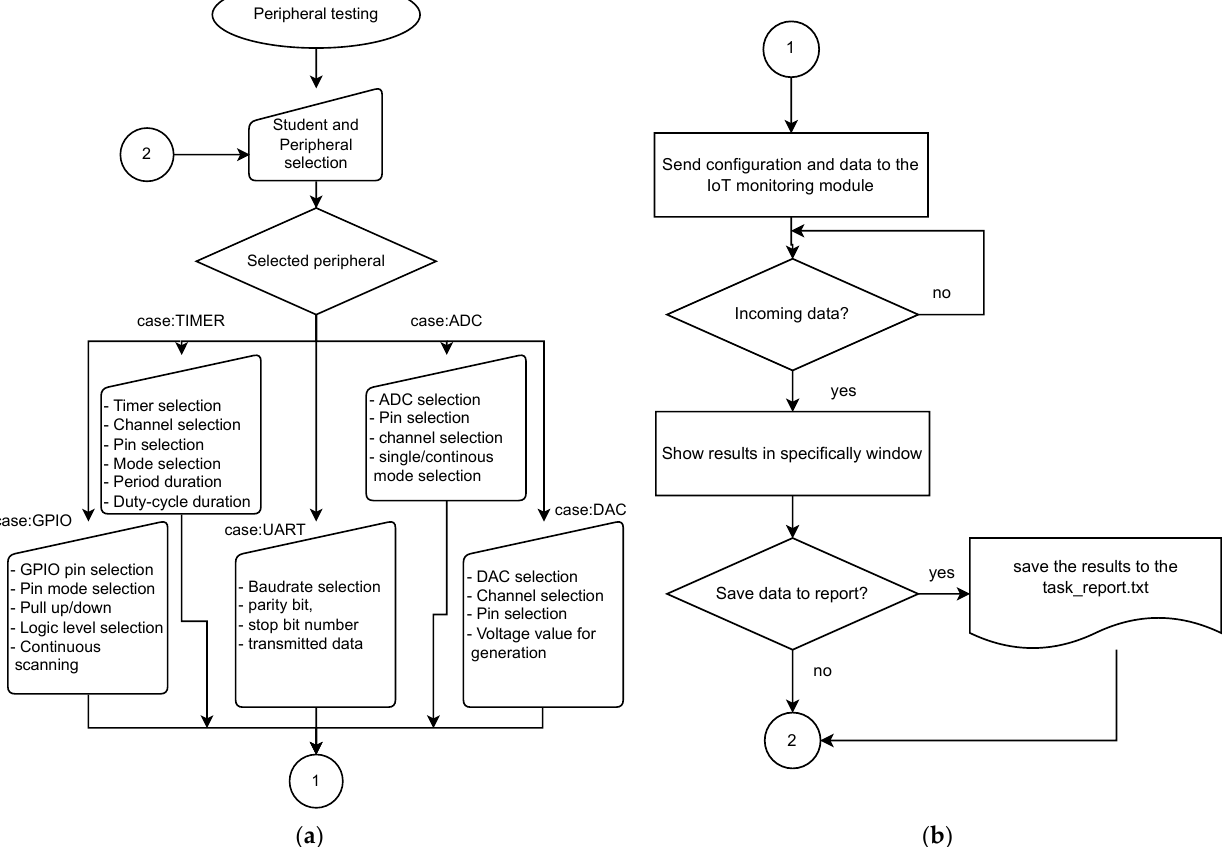
Figure 6. The shown flowcharts mainly create control application functions. The first part marked as ( a ) describes the selection of the tested peripherals and the manual input of peripheral configurations, or the selection of data sent to the server and subsequently to the IoT monitoring device. The ( b ) is a continuation of the first part of the algorithm, which describes the method of receiving the response from the IoT monitoring device, its display and storage in the report.